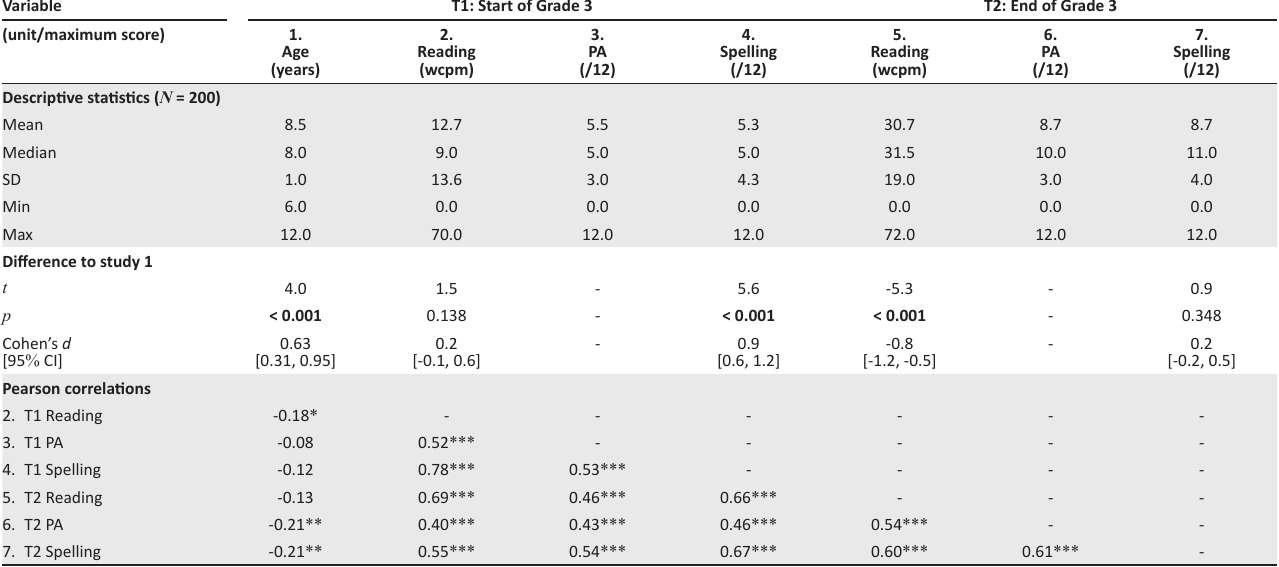
TABLE 3: Study 2: Descriptive statistics, effect-size difference (Cohen’s d ) to study 1 and Pearson correlations for phonological awareness, reading, spelling and age. Variable